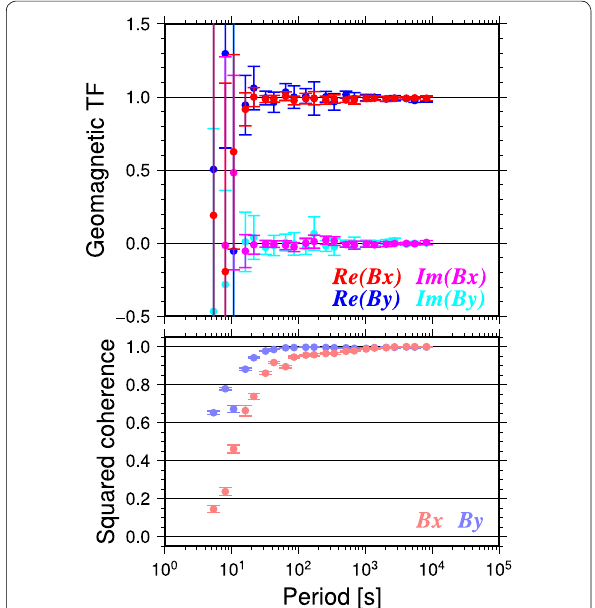
Fig. 4 Geomagnetic transfer functions and squared coherences between the new and conventional magnetometer systems at site OBM1. Bx and By indicate north and east components of geomagnetic field, respectively. The error bars represent 95% confidence intervals. The same geomagnetic signal is recorded when the real and imaginary components are 1 and 0,